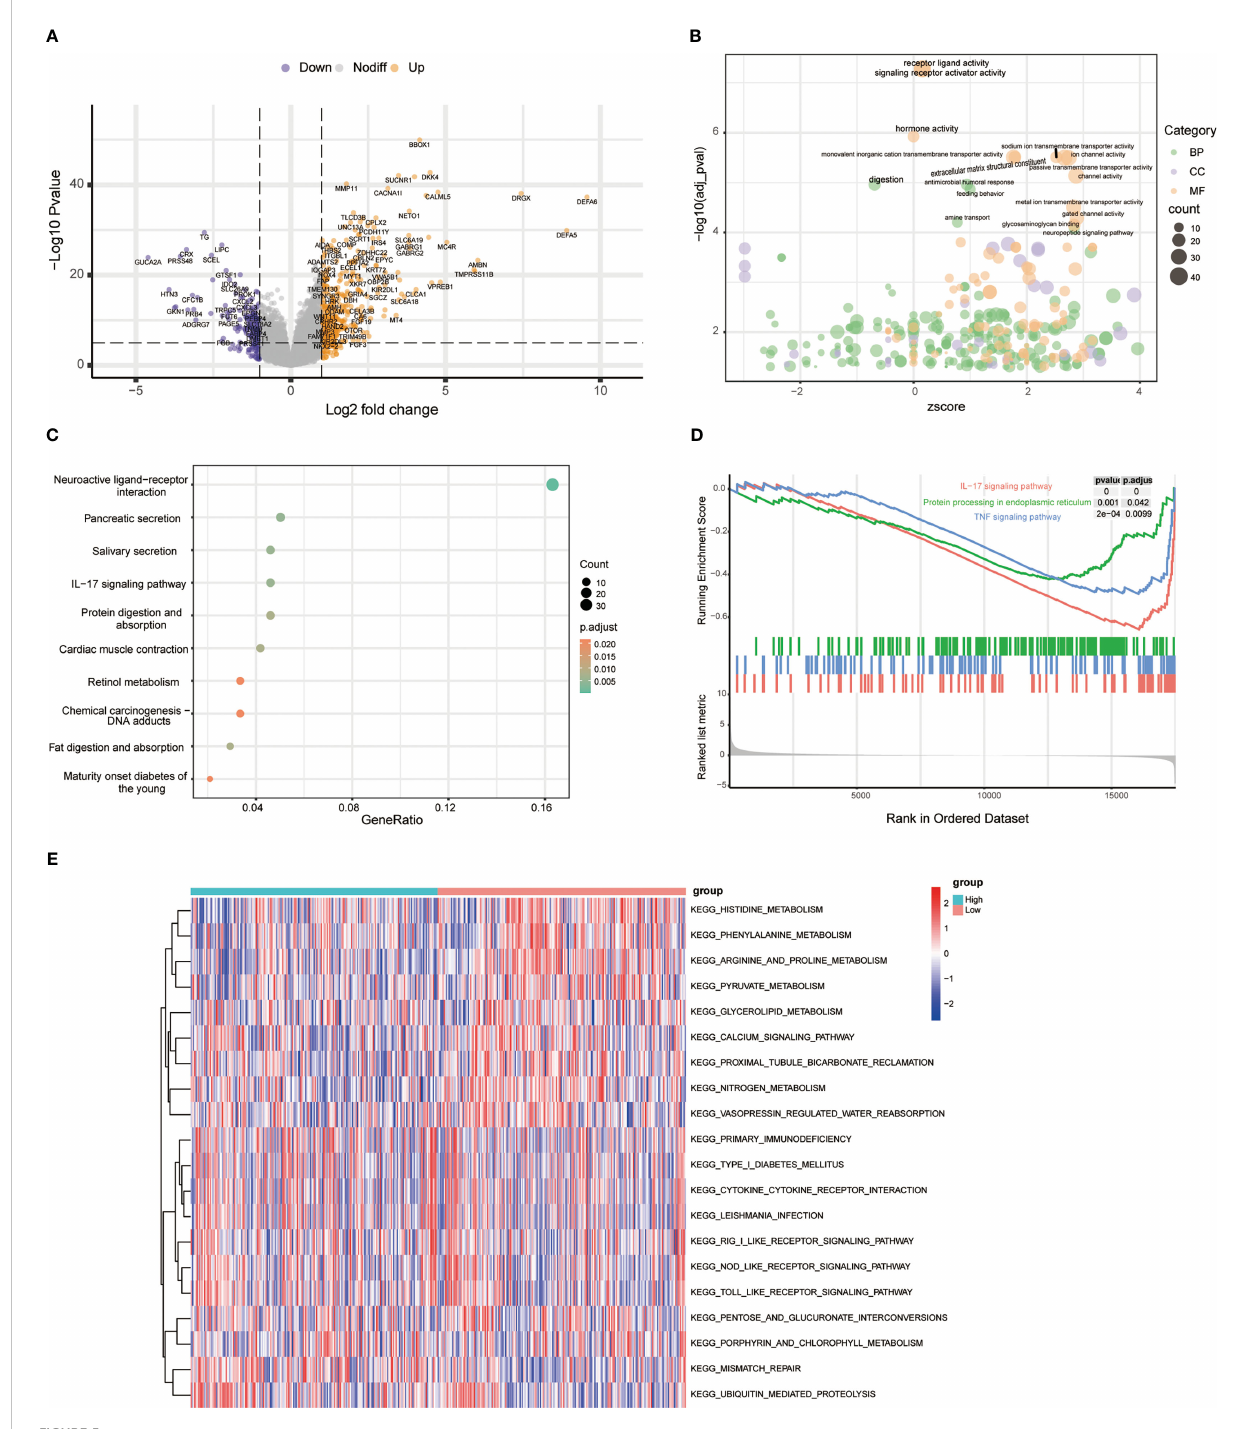
FIGURE 5 Functional enrichment analysis between risk types. (A) Volcano plot of differentially expressed genes between high- and low-risk groups. (B) Bubble chart showing GO terms of differentially expressed genes between different risk types. (C) Top 10 KEGG pathways of differentially expressed genes between different risk types. (D) GSEA results between high-risk and low-risk groups. (E) The heatmap shows the top 10 upregulated and top 10 downregulated GSVA scores for KEGG pathways grouped by high- and low-risk